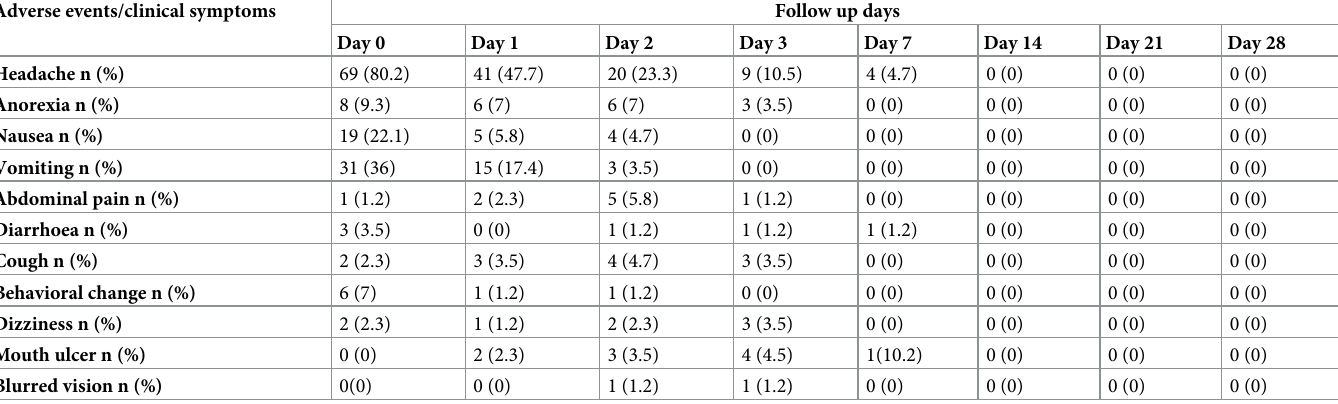
Table 5. Common malaria clinical signs and symptoms and adverse events following Chloroquine treatment in Shewa Robit Health Centre, northeast Ethiopia from November 2020 to March 2021. Adverse events/clinical symptoms Follow up